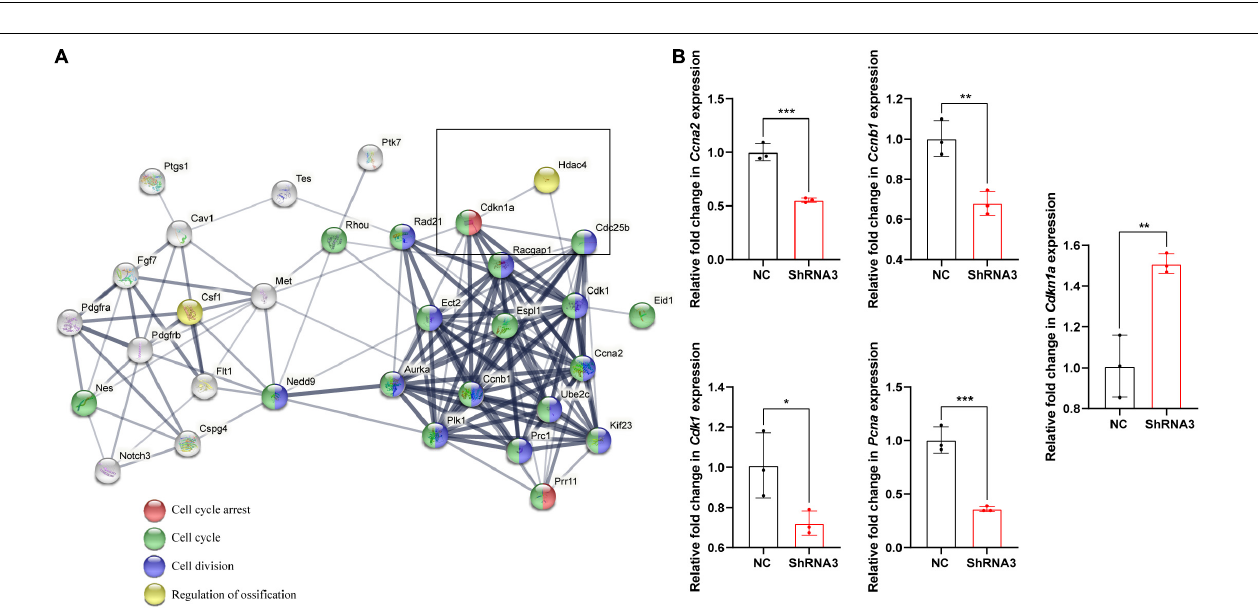
FIGURE 4 | RNA sequencing of MC3T3-E1 cells transfected with scramble or shRNA3 lentivirus ( n = 3). (A) Volcano plots for all the genes of the control and Hdac4-shRNA3 groups. Green dots on both sides indicate up- and downregulated differentially expressed genes (DEGs; p -adj < 0.05). (B) The top 10 GO terms associated with biological processes ( p -adj < 0.05) involving the downregulated genes in the Hdac4-shRNA3 group. (C) The top 10 enriched KEGG pathways associated with the downregulated genes ( p -adj < 0.05) in the Hdac4-shRNA3 group.